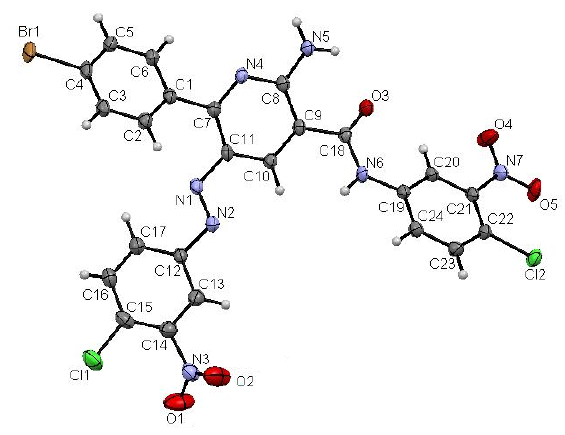
Figure 4. ORTEP plot of the X-ray crystallographic data determined for 18